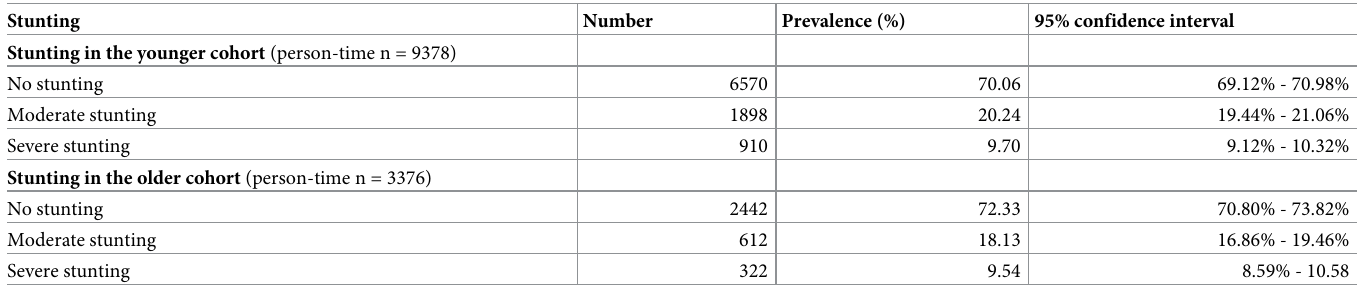
Table 2. Longitudinal prevalence of stunting from childhood to youthhood, Ethiopia,